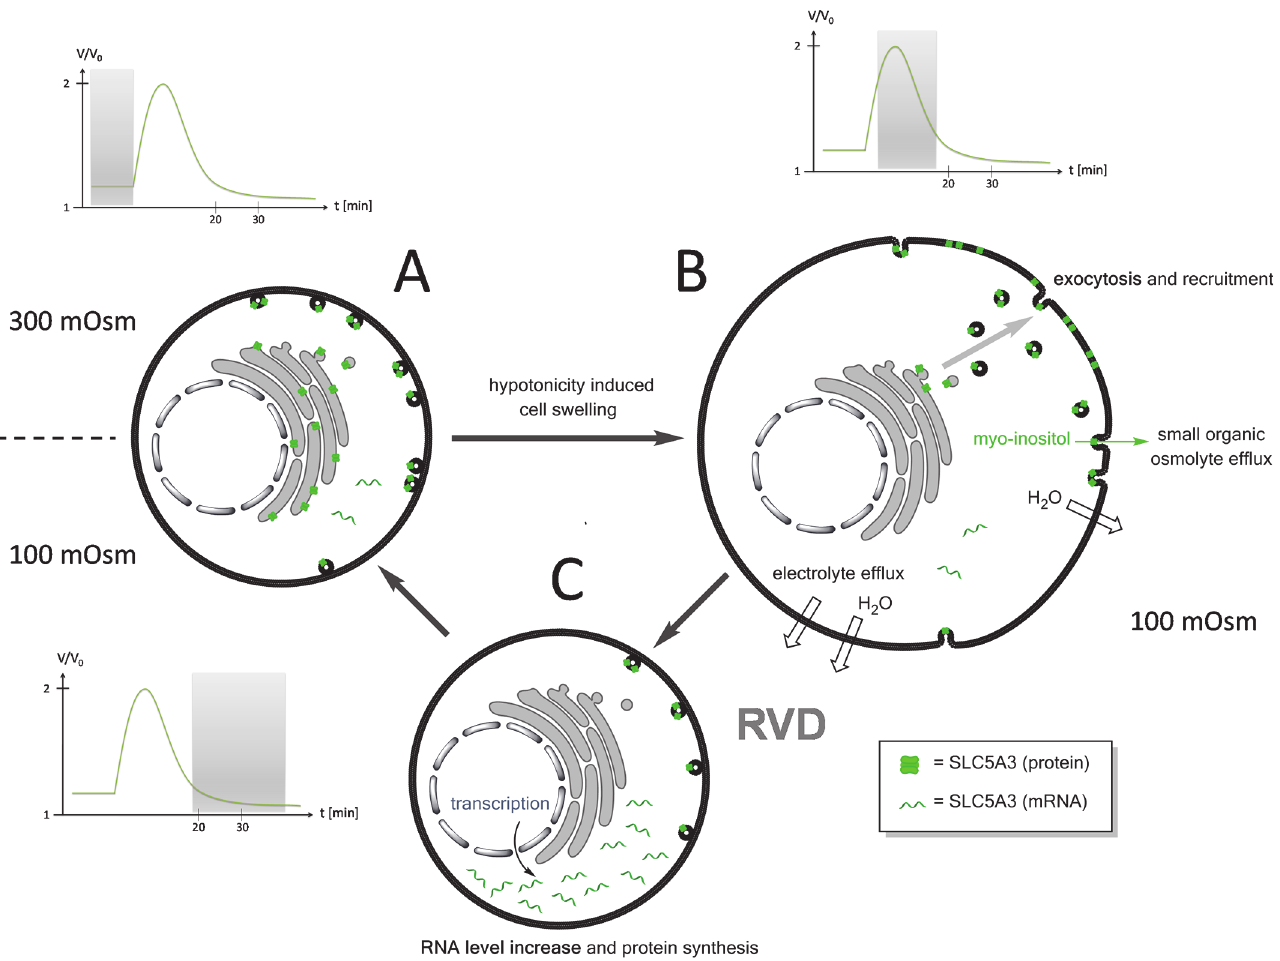
Fig 7. A putative mechanism of SLC5A3-mediated myo-inositol release during RVD. A: Under isotonic conditions the SLC5A3 protein is mainly localized in the cytosolic vesicles and its mRNA level is low. The plasma membrane permeability to SOOs and electrolytes is poor. B: Exposure of cells to a strongly hypotonic solution, e.g. 100-mOsm sucrose, causes rapid volume increase followed by cell shrinkage via RVD (see Fig. 1). The swelling-associated increase in the plasma membrane area is achieved (i) by unfolding of microvilli and (ii) by exocytotic fusion of cytosolic vesicles [23]. The fusion of vesicles carrying SLC5A3 protein leads to the incorporation of this transporter into the plasma membrane. The SLC5A3-mediated efflux of myo-inositol and related SOO contributes to cell shrinkage (RVD) and restoration of the original isotonic cell volume. C: During RVD, the cells recover the original membrane impermeability to myo-inositol (Fig. 1), presumably, via the endocytosis of excessive plasma membrane along with reinternalization and, possibly, lysosomal degradation of SLC5A3. The increased mRNA and protein expression of SLC5A3 (Fig. 6) suggest that de novo synthesis of SLC5A3 occurs to restore the depleted cytoplasmic pool of the